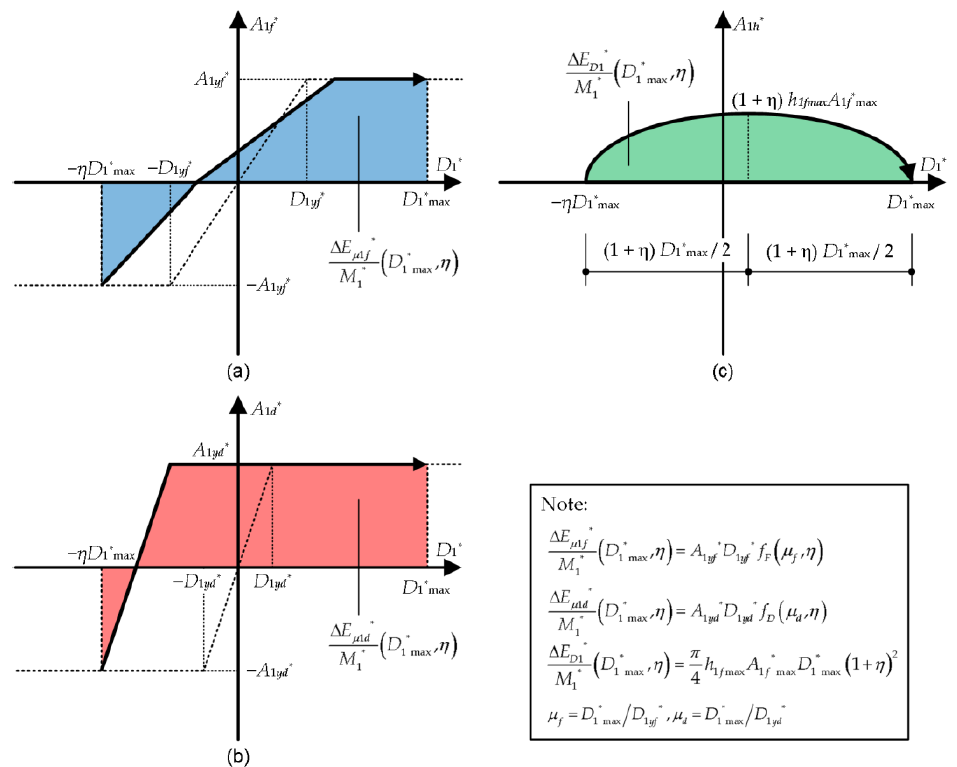
Figure A1. Simplified models for calculation of the dissipated energy during a half cycle of the structural response: ( a ) contribution of RC MRFs; ( b ) contribution of steel damper columns; ( c ) con- tribution of viscous damping.